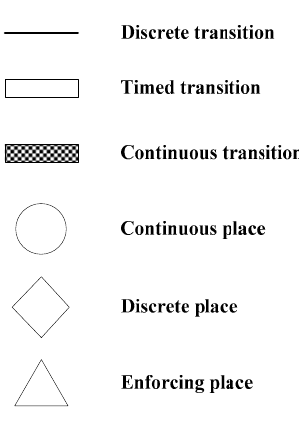
Figure 1. Icons in the model.